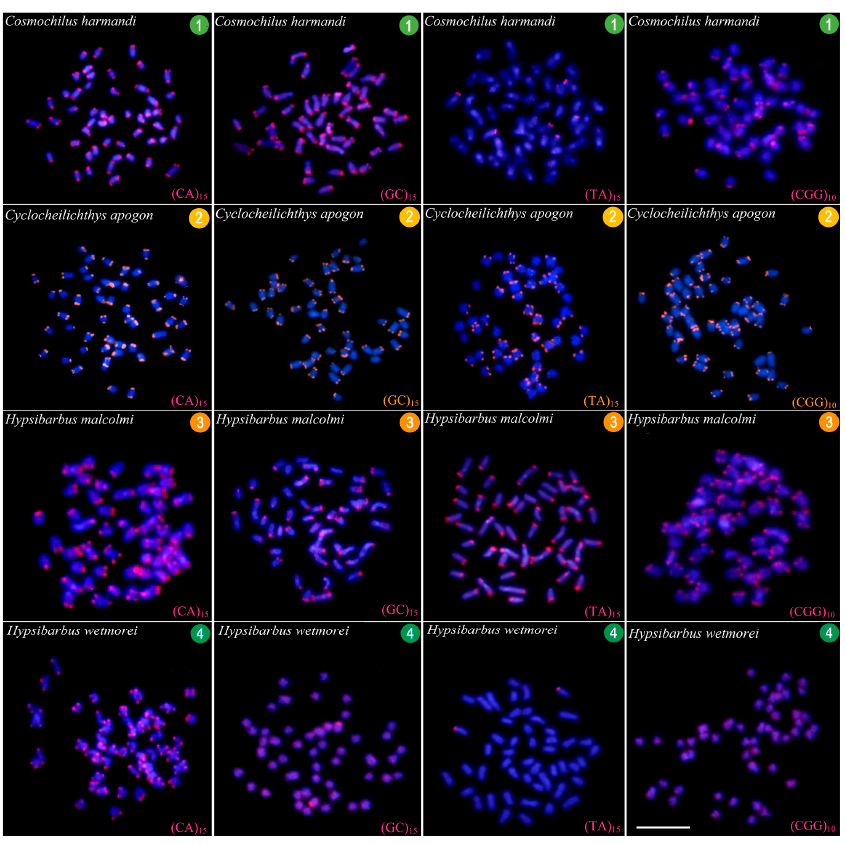
Figure 5. Metaphase plates of Cosmochilus harmandi , Cyclocheilichthys apogon , Hypsibarbus malcolmi , and Hypsibarbus wetmorei after FISH with di ff erent microsatellite motifs. Scale bar = 5 µm.